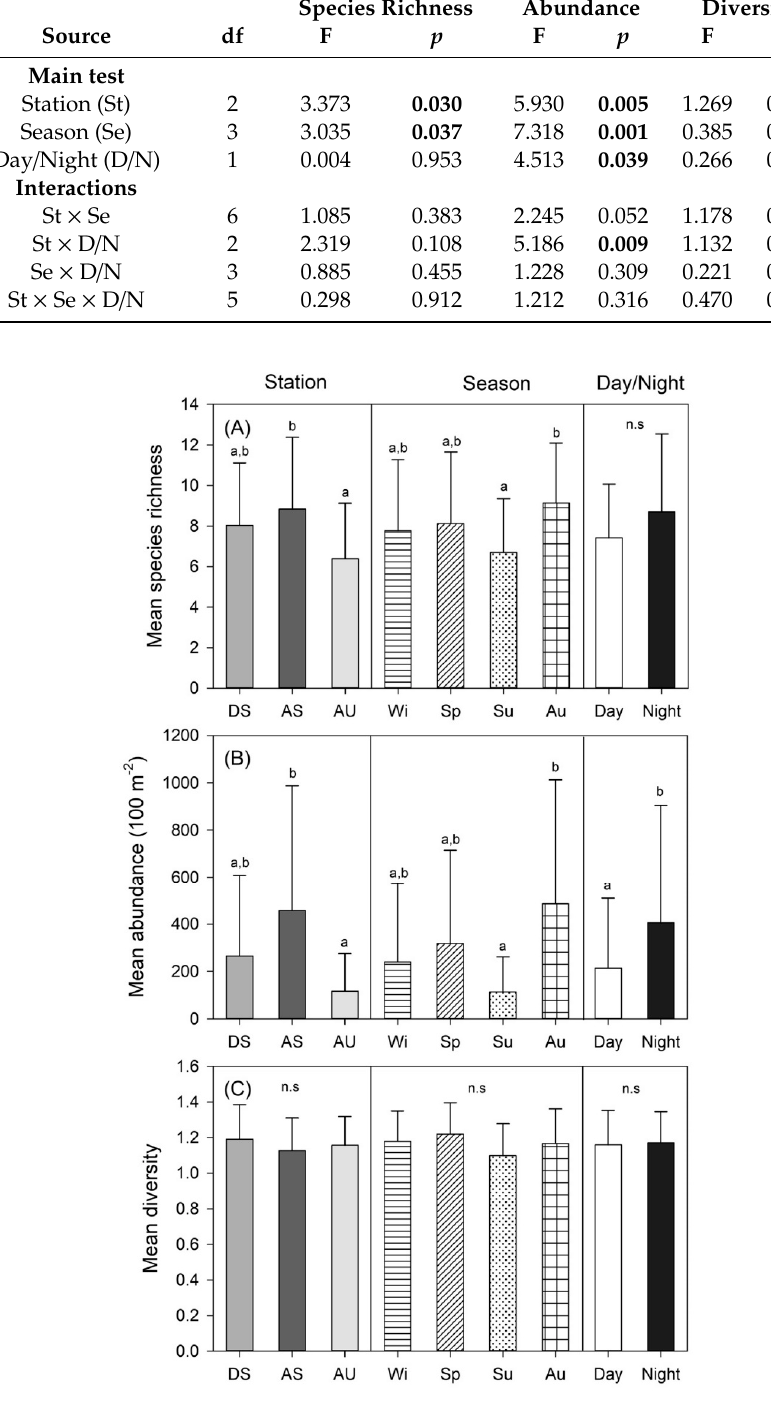
Figure 2. Mean species richness ( A ), abundance ( B ), and diversity ( C ) of decapod assemblages with station, season, and diel patterns. DS = seagrass beds in Dongdae Bay, AS = seagrass bed in Aenggang Bay, AU = unvegetated habitat in Aenggang Bay; Wi = winter, Sp = spring, Su = summer, Au = autumn.